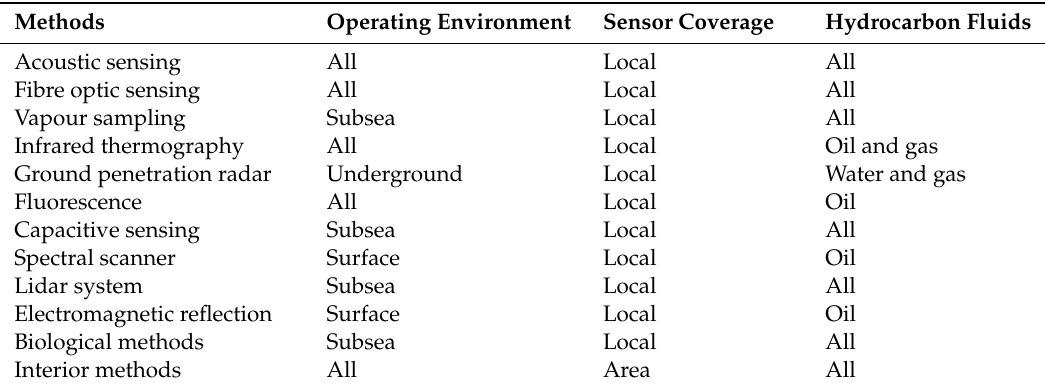
Table 4. Summary of the guidelines for method